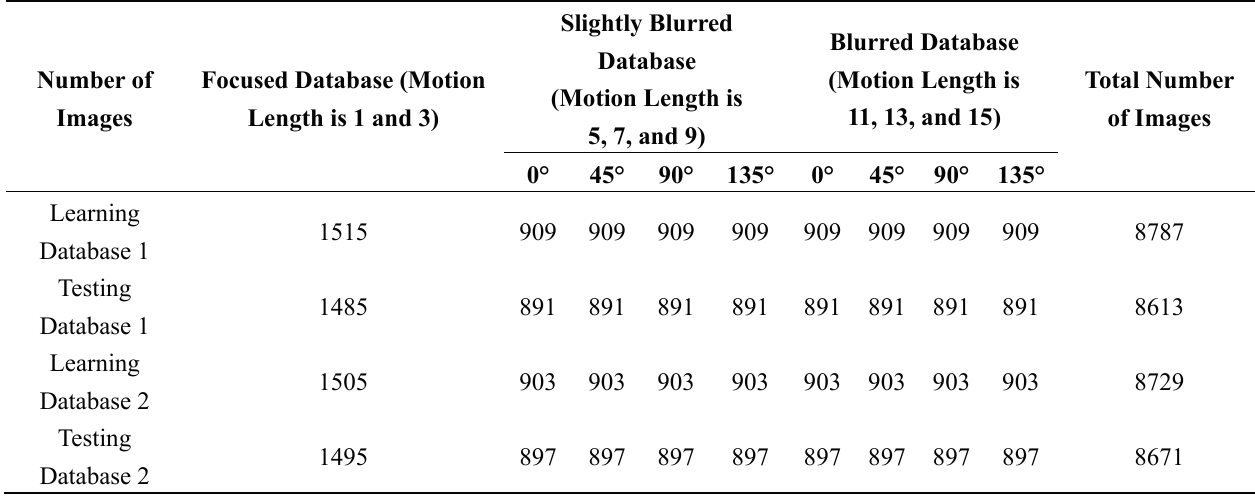
Table 9. Description of the new motion blur database obtained from MORPH database used in our experiments.